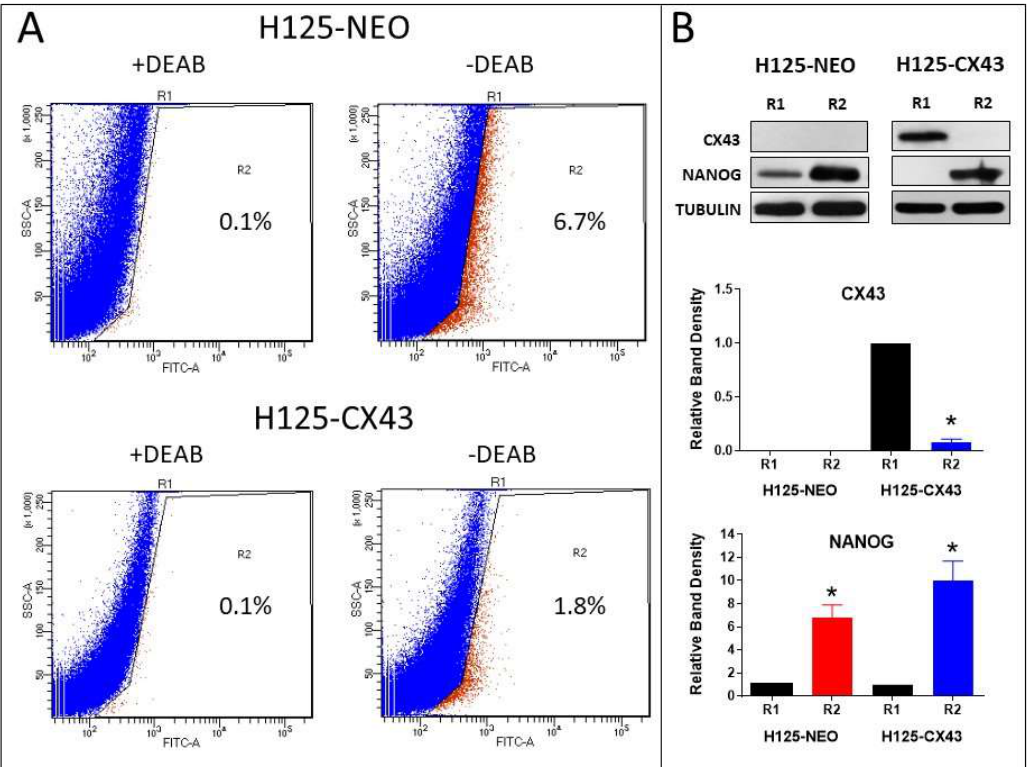
Figure 7. Connexin43 reduces the population of aldehyde dehydrogenase (ALDH)-positive H125 cells. ( A ) Dot plots of fluorescence assisted cell sorting (FACS)-sorted ALDH-low (R1 pool) and ALDH-high (R2 pool) with and without DEAB in H125-NEO and H125-CX43 cells; the percentages of R2 cells are shown on the plots. ( B ) Western blots of Cx43 and Nanog in R1 (ALDH-low) and R2 (ALDH-high) populations of H125-NEO and H125-CX43 cells; band densities were normalized to tubulin loading control and to R1 cells (* p < 0.01 compared to R1 cells, one-sample t -test, mean ± S.D., n = 3 replicate experiments).